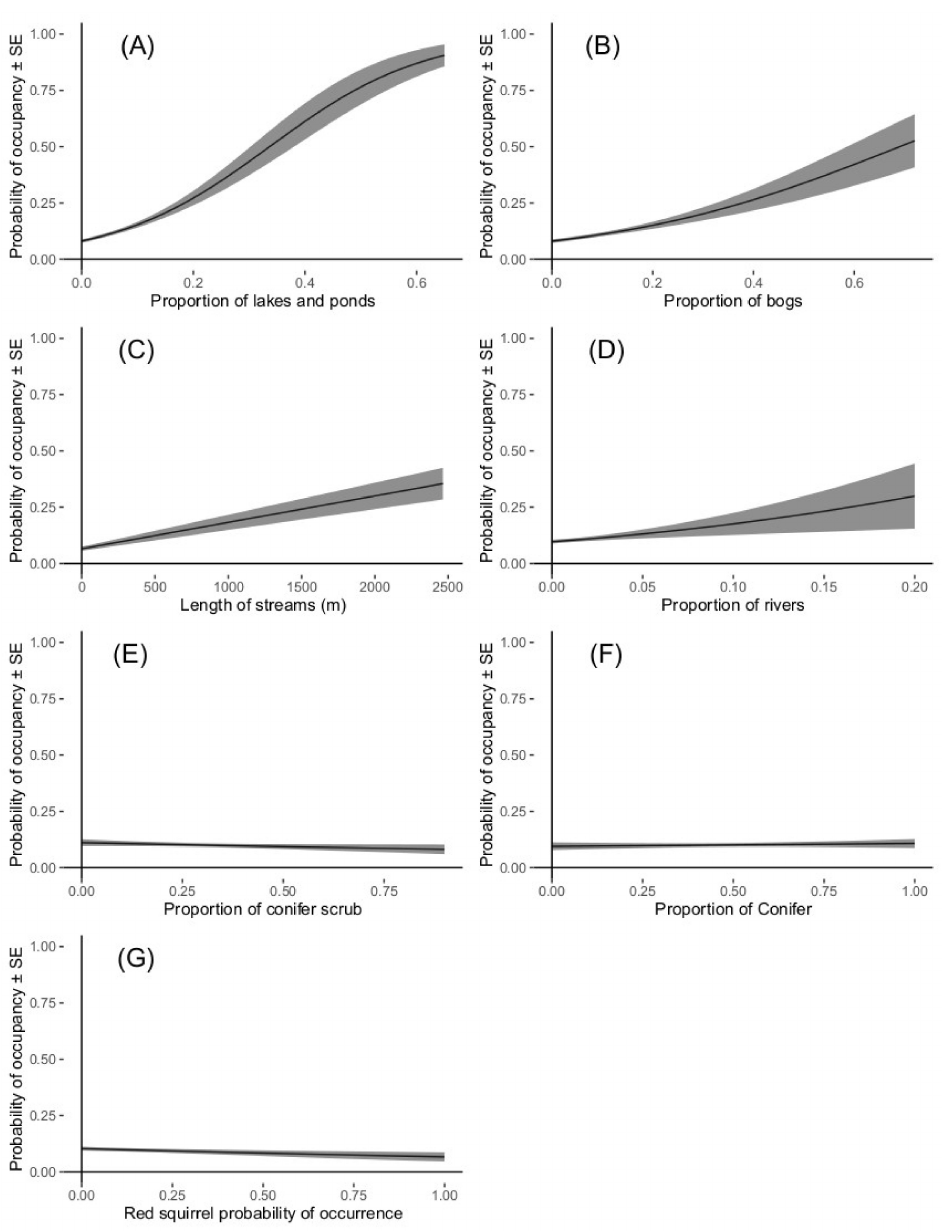
Figure 2. Relationship between rusty blackbird probability of occurrence and landcover variables found in our highest-ranked occupancy models ( A – F ), as well as with red squirrel occurrence ( G ), in Newfoundland, Canada, in 2016 and 2017 ( n = 1960). Landcover variables were ( A ) proportion of lakes and ponds ( B ) proportion of bogs ( C ) length of stream ( D ) proportion of rivers, ( E ) proportion of conifer scrub, ( F ) proportion of conifer forest, and ( G ) red squirrel probability of occurrence. Each variable was plotted using the best model that included that factor (Table 3). Error bars show one standard error. Note that while the vertical axis is the same for all plots, the scale and units of the horizontal axis